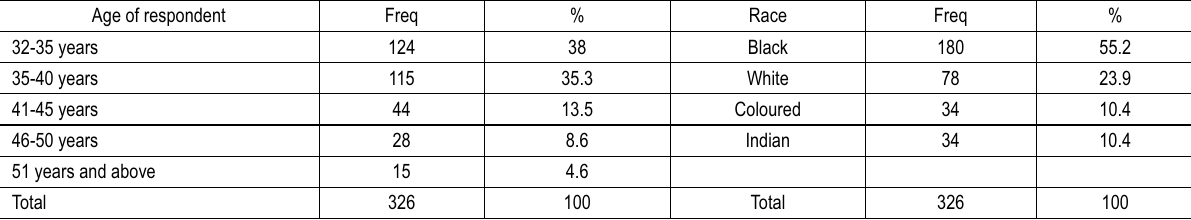
Table 1. Respondents characteristics (age and